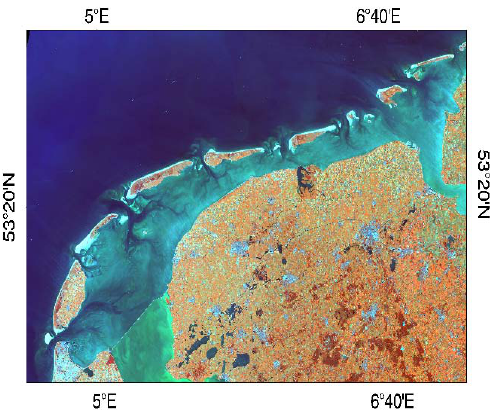
Figure 1. One Landsat-8 OLI image covering the Dutch Wadden Sea and parts of IJsselmeer lake acquired on 20 July 2016 (Color composite of red = band 5, green = band 3 and blue = band